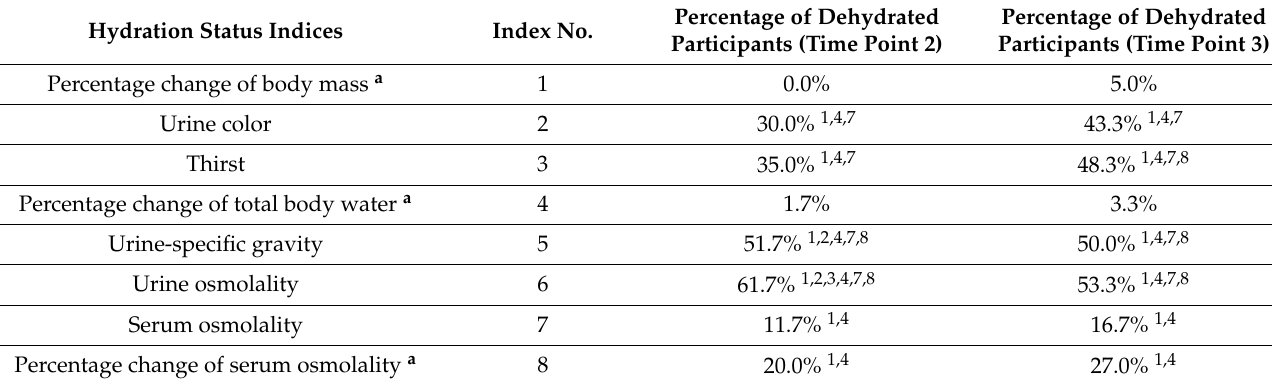
Table 5. Percentage of dehydrated participants depending on the hydration status